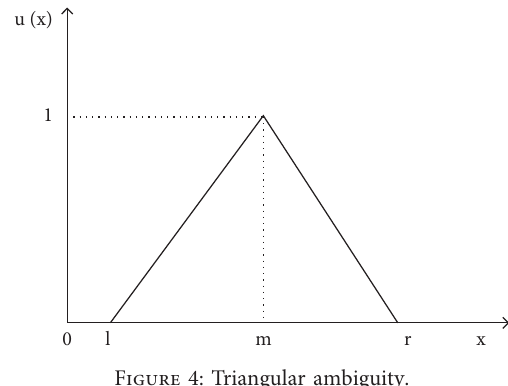
Figure 4: Triangular